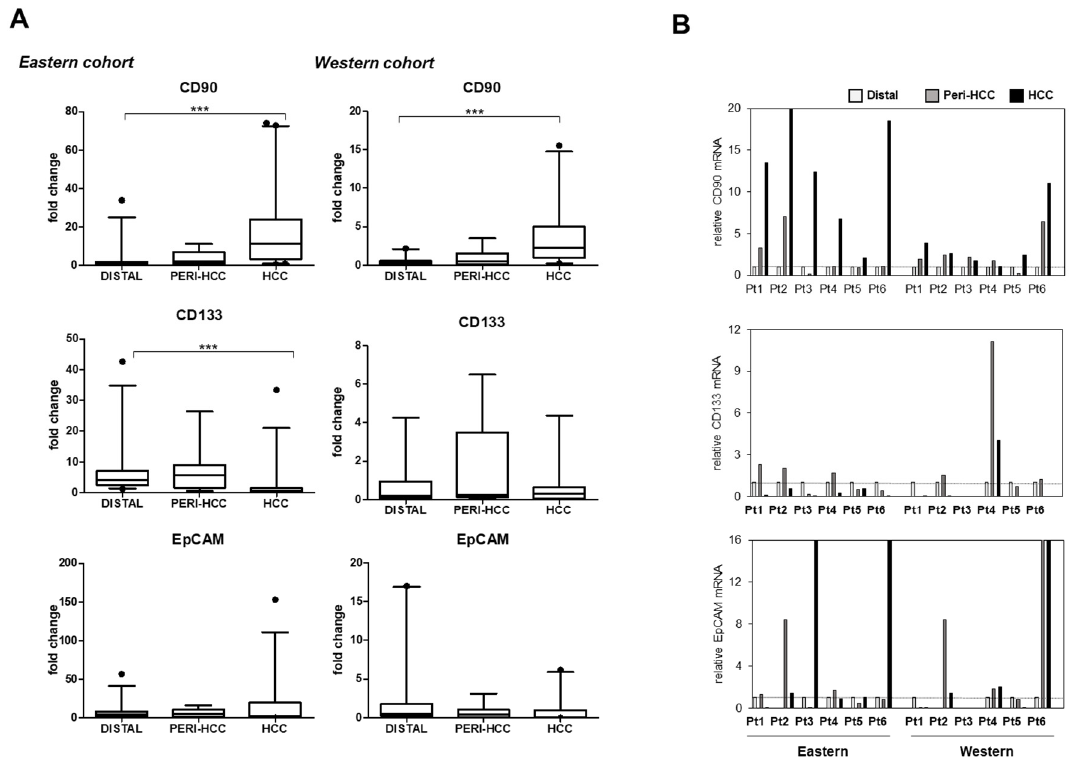
Figure 1. Distribution of CSC markers in the Eastern and Western cohorts. ( A ) mRNA expression of CSC markers CD90 / THY-1, CD133 / Prom-1, and EpCAM / CD326 in distal, peri-HCC, and HCC tissues. The expression of a sample was considered as 1.0. *** p < 0.001. Graphs are represented as median (bar) and 95% CI. ( B ) mRNA expression of CSC markers in six representative patients of each cohort shows clear up-regulation of CD90. Distal = 1.0, Pt = patient. The target gene was normalized to two reference genes ACTB and 18sRNA.